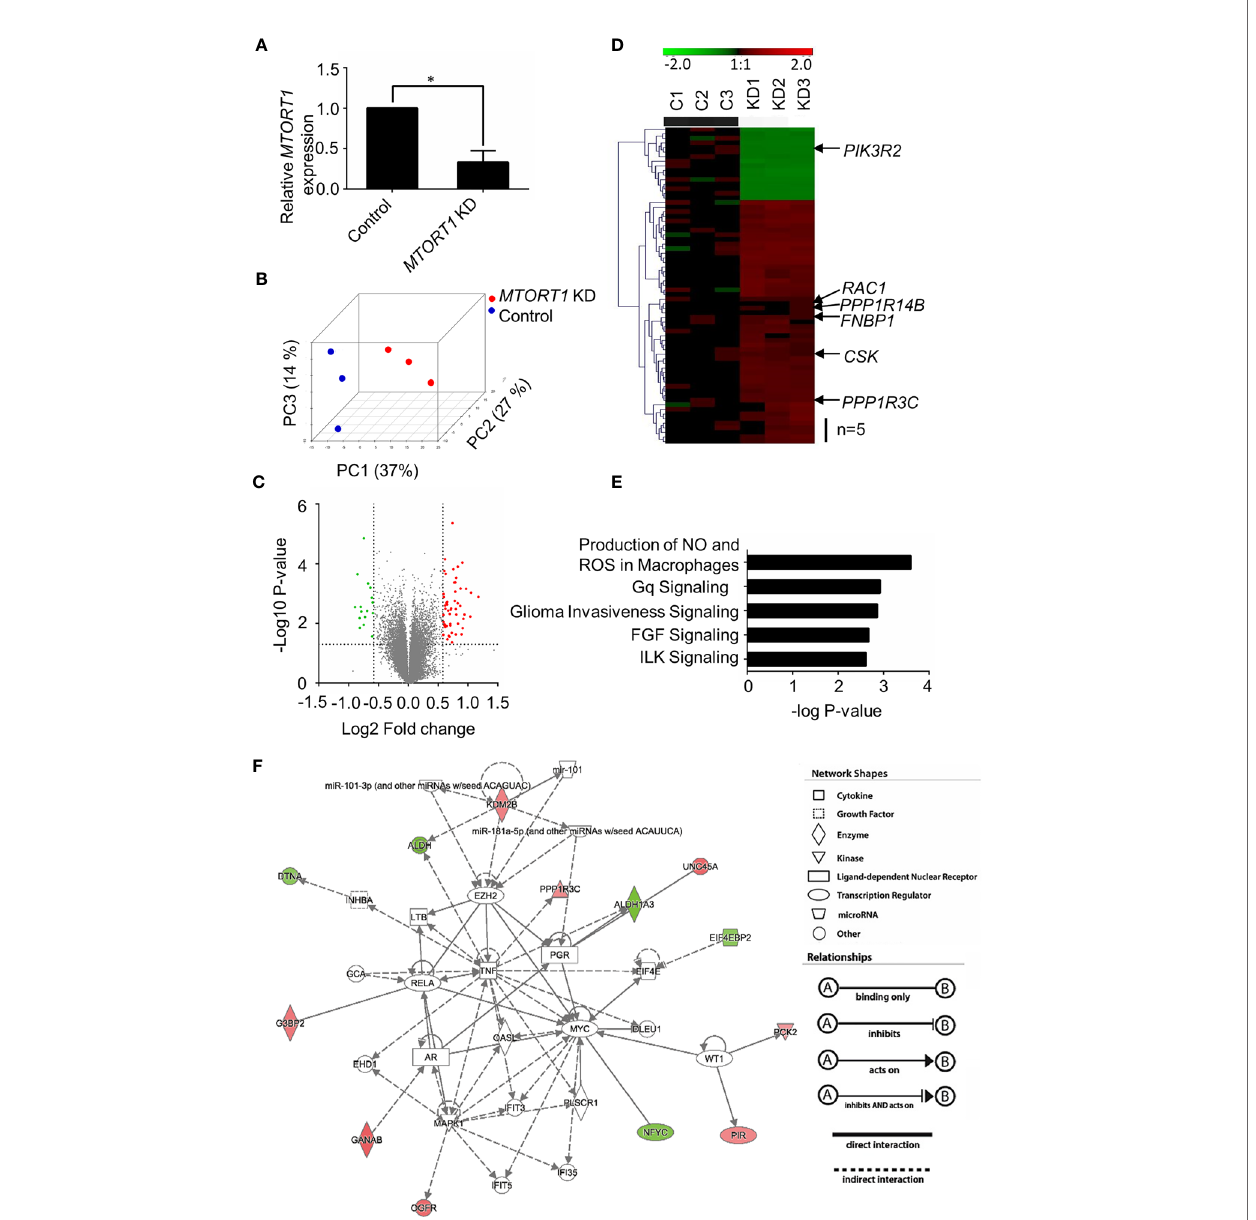
FIGURE 2 | Identi fi cation of MTORT1 -downstream genes by microarray analysis. (A) Relative expression levels of MTORT1 in MCF-7 cells treated with siRNA against MTORT1. Expression levels were measured by quantitative RT-PCR and normalized to 18S rRNA. * P < 0.05. (B) Principal component (PC) analysis of MTORT1 knockdown (KD) cells. PCs were plotted by the expression pro fi les of differentially expressed probes after quantile normalization. Each dot represents a sample. (C) Volcano plot of differentially expressed genes in MTORT1 knockdown cells. Red points: up-regulated genes in MTORT1 knockdown cells; green points: down-regulated genes; gray points: non-signi fi cant genes. (D) Heatmap and hierarchical cluster analysis of MTORT1 -downstream genes. The labeled genes were validated by quantitative RT-PCR. Red color: up-regulated genes in MTORT1 knockdown cells; green color: down-regulated genes; black color, non-signi fi cant genes. (E) The top fi ve canonical pathways that MTORT1 -downstream genes were enriched in, according to Ingenuity Pathway Analysis. (F) Representative network of MTORT1 -downstream genes involved in cellular development, cellular growth, and proliferation. Red shapes represent genes that were up-regulated in MTORT1 knockdown cells; green shapes represent down-regulated